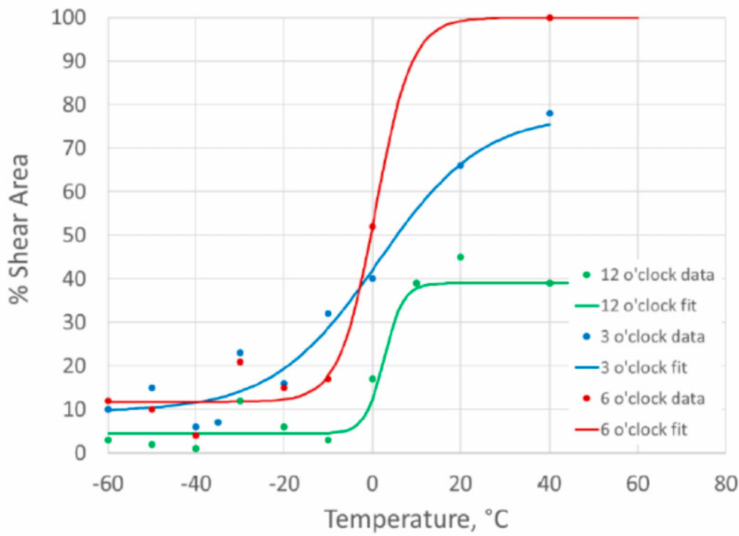
Figure 8. Charpy percent shear area ductile-to-brittle transition curves for weld centerline notched